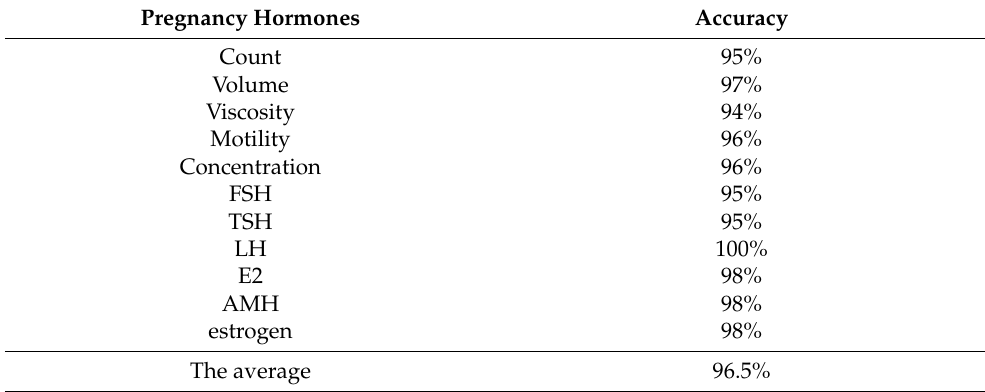
Table 8. Proportion of correctly classified hormones.